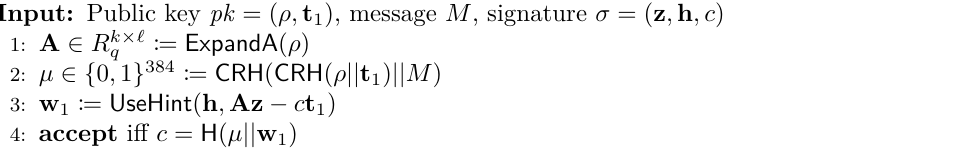
Algorithm 3 Dilithium Verify (simplified 4